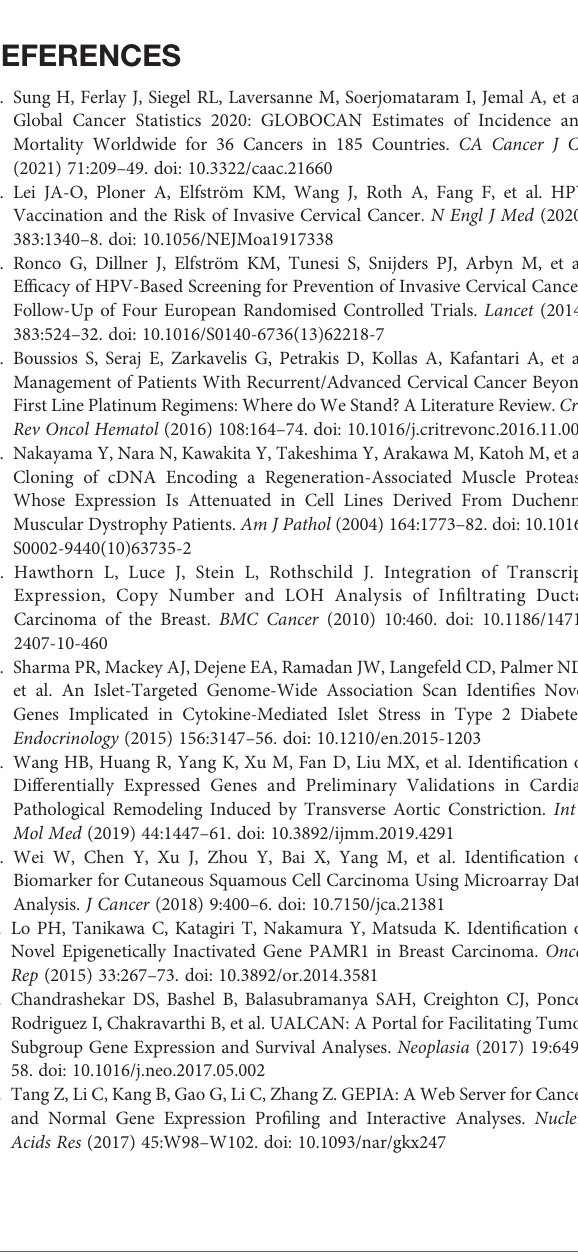
Supplementary Figure S5 | Bubble diagram of Top C6 oncogenic signature gene sets enriched by high expression (A) or low expression (B) of PAMR1 in TCGA-CESC data using GSEA. (C) Bar plot of GO analysis of PAMR1 base on TCGA-CESC data. Supplementary Figure S6 | (A) Correlation analysis between PAMR1 and MYC, ATF4, MXD3, MLST8, MTOR, ULK1 and MAPKAP1 in TCGA-CESC dataset. r and p values were shown in the top of each diagram. (B) Correlation Analysis between PAMR1 and MYC, ATF4, MXD3, ULK1 and MAPKAP1 in GSE44001 dataset. r and p values were shown in the top of each diagram. (C) The expression of PAMR1 in MYC deleted HeLa cells from GSE143517 dataset, p = 0.2216. (D) The expression of PAMR1 in OVCAR-3 cells after treatment with mTORC1/2 inhibitor INK128 from GSE116387 datasets, p = 0.4901. Supplementary Figure S7 | The protein levels of ULK1, MAPKAP1, ATF4, PAMR1 (A) and LC3-I, LC3-II, SQSTM1/p62 (B) were analyzed by Western blotting when overexpression or knockdown of PAMR1 in HeLa cells. *p < 0.05, **p < 0.005, ***p < 0.0005, ****p < 0.0001.